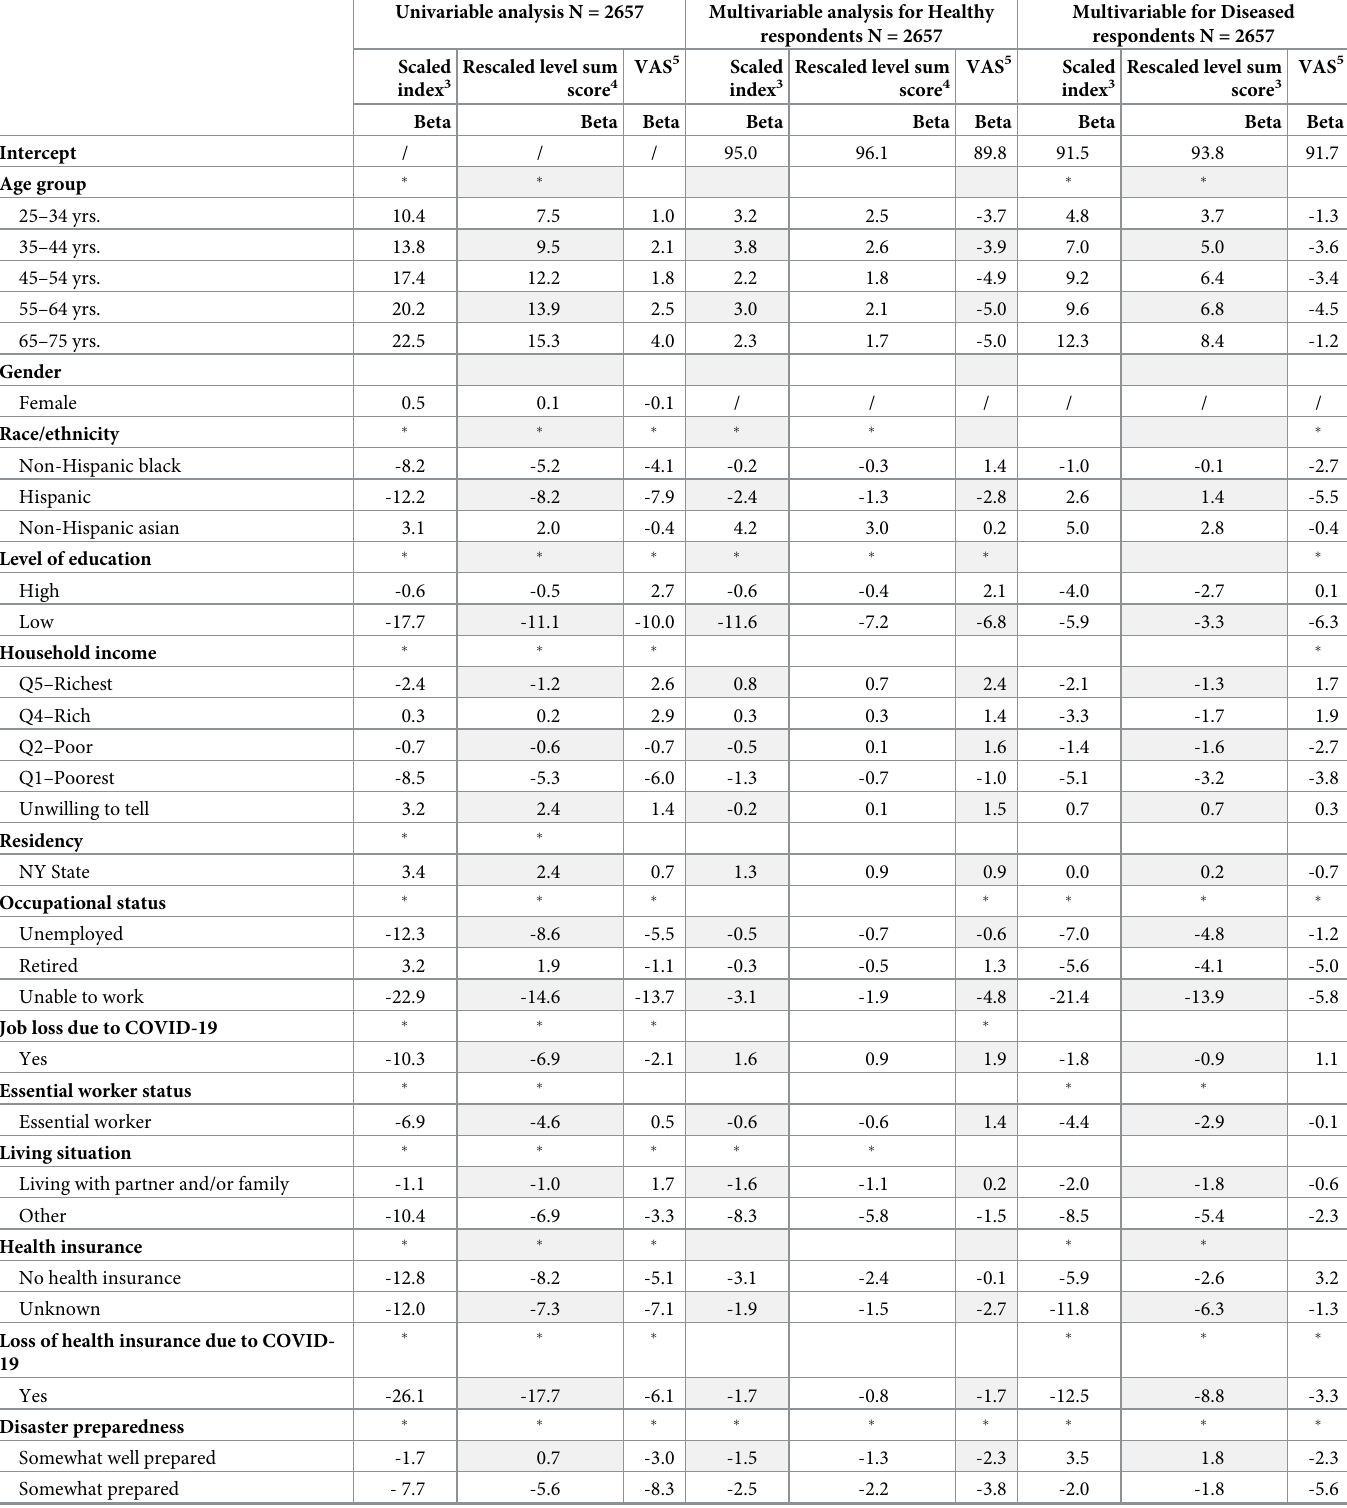
Table 3. EQ-5D-5L index, level sum score, and EQ VAS, univariable and multivariable analysis in healthy and diseased respondents 1 , 2